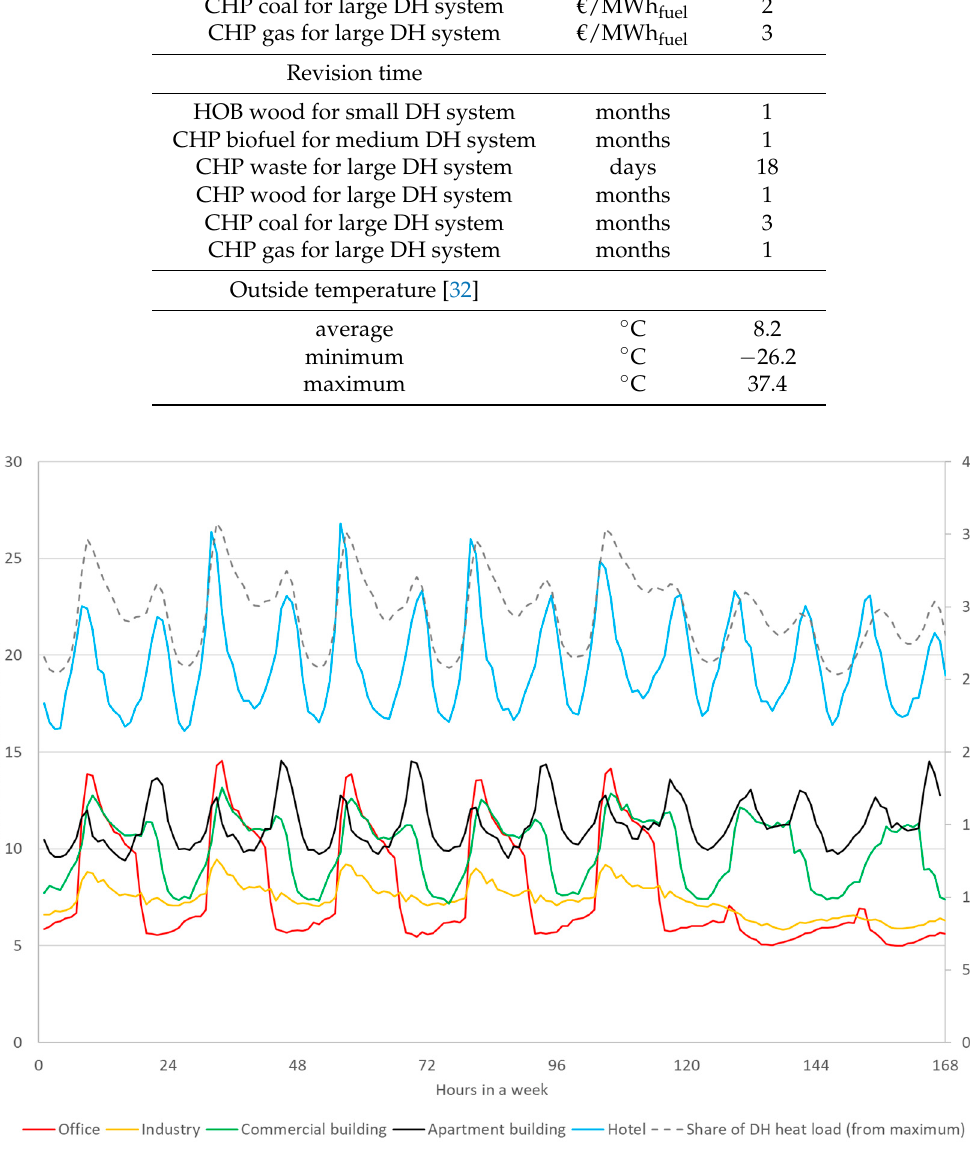
Figure A1. Average weekly heat peak load patterns for different customer segments for year 2016 (primary vertical axes) and average weekly share of DH load (secondary axes).